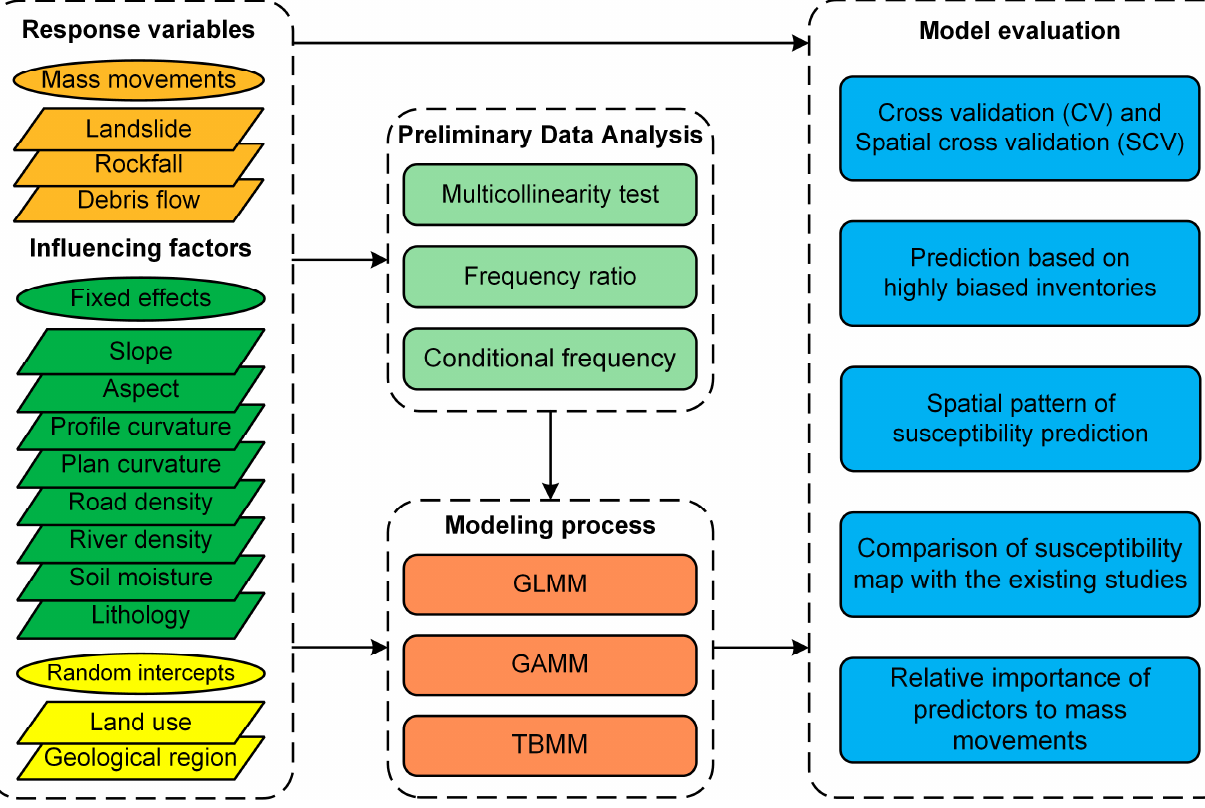
Figure 4. Workflow performed in this study.